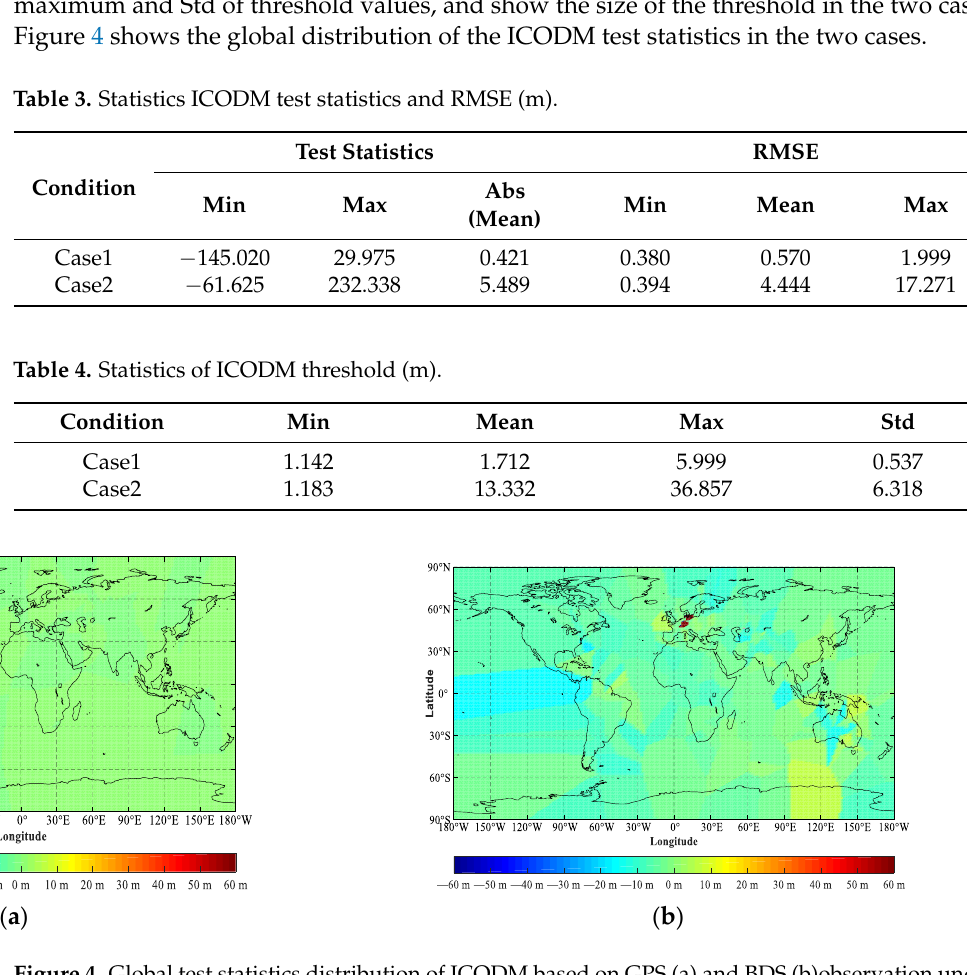
Figure 4. Global test statistics distribution of ICODM based on GPS (a) and BDS (b)observation under case1 and case2.